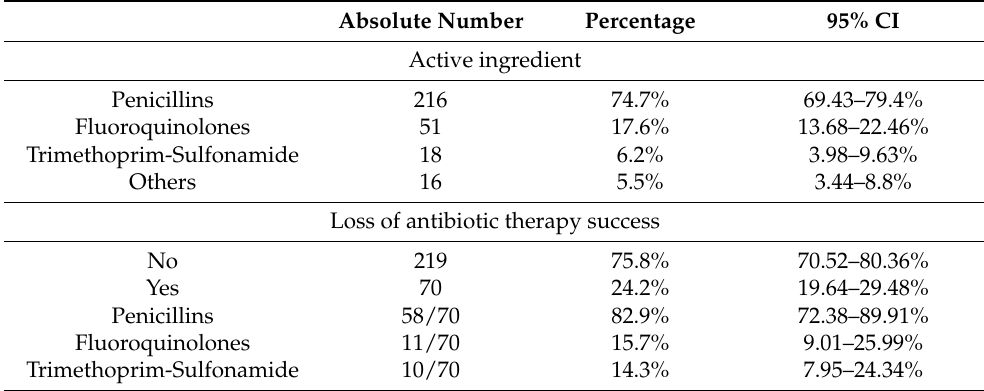
Table 3. Cystitis. Number, percentages, and 95% CI of responses regarding the disease of cystitis according to the frequency of the used active ingredients and the antibiotic groups for which a loss of therapeutic success was observed. A total of 289 questionnaires from a survey among German veterinarians were analyzed for this evaluation.